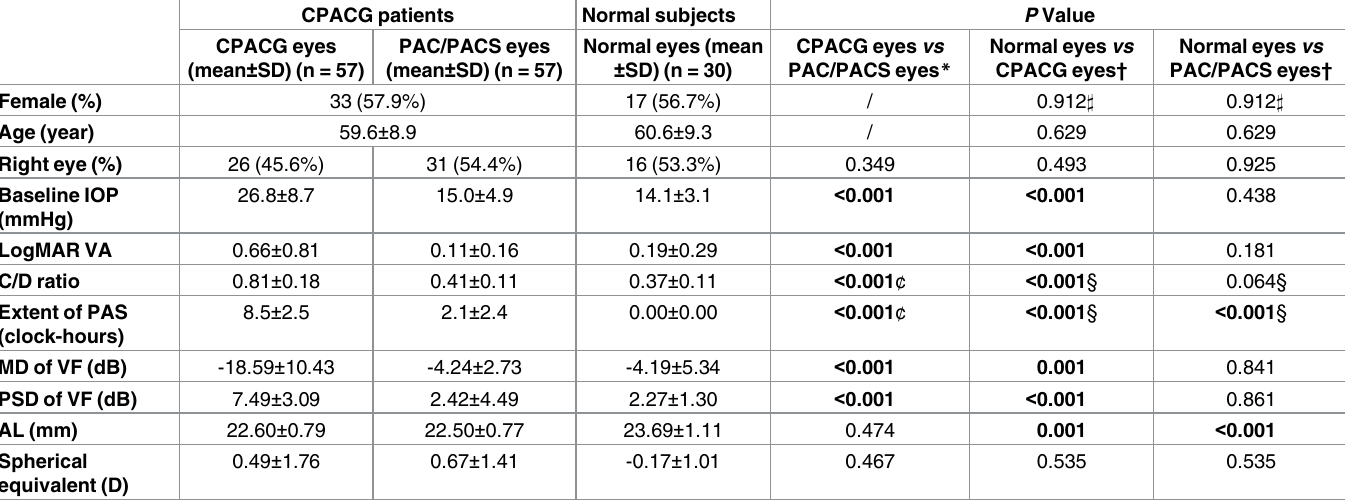
Table 1. Demographic and biometric characteristics of CPACG patients (CPACG eyes vs fellow PAC/PACS eyes) and normal